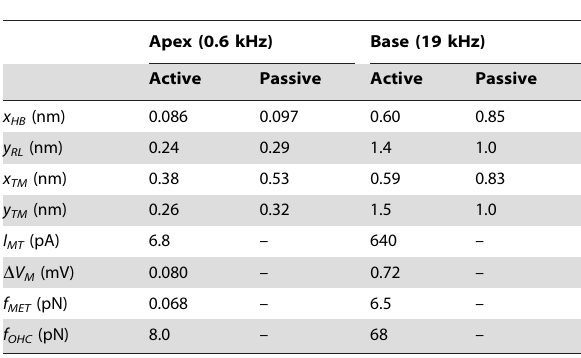
Table 2. OC responses per 1 nm basilar membrane